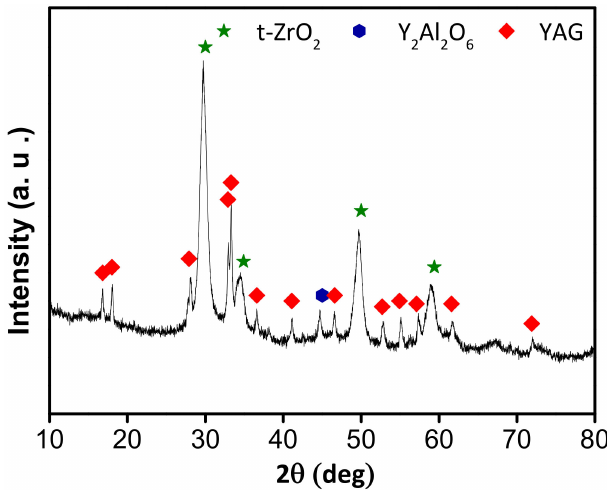
Figure 4. The X-ray powder di ff raction (XRD) pattern of AYZ powder after calcination at 850 ◦